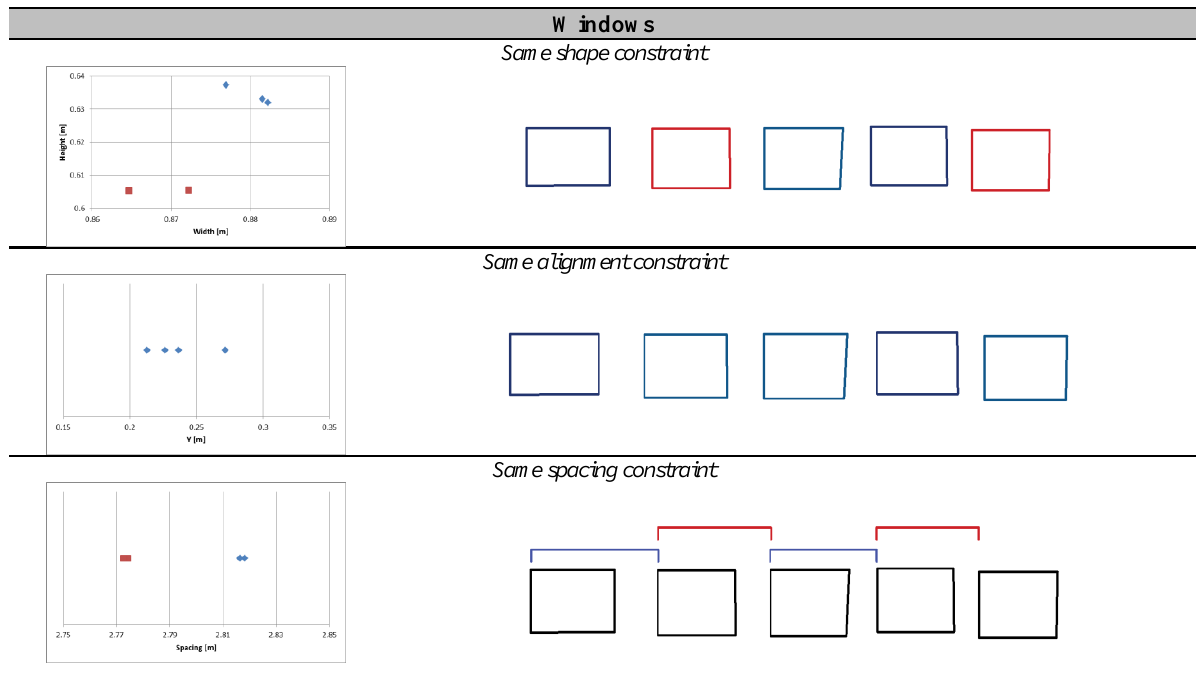
Figure 5: Detected constraints for the building windows: the detected clusters with means shift clustering are represented with different colours (left), and the related features are highlighted with the same colour